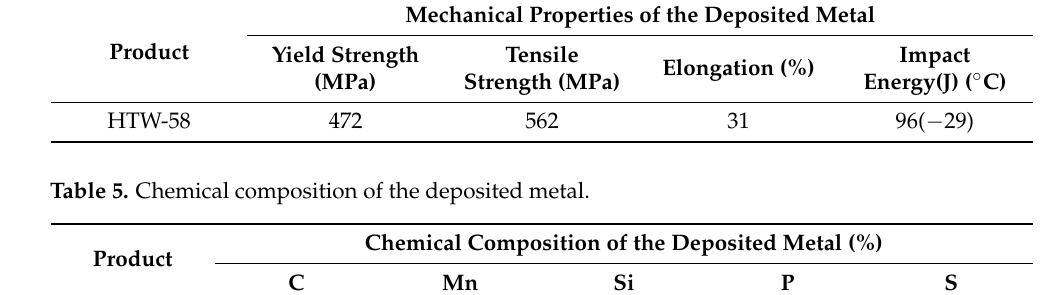
Table 4. Mechanical properties of the deposited metal.